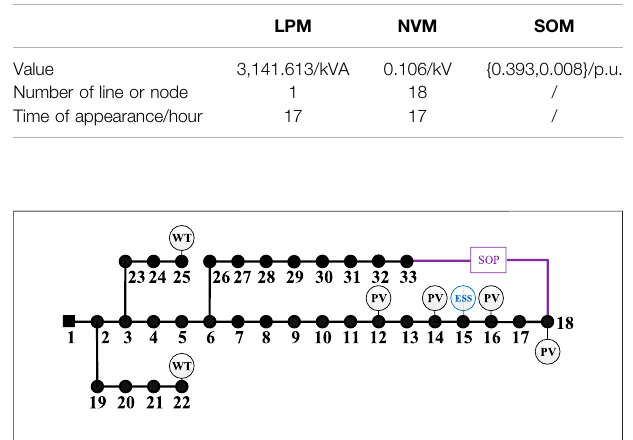
FIGURE 10 | Integration ofcontrollable devices in the IEEE 33-node test